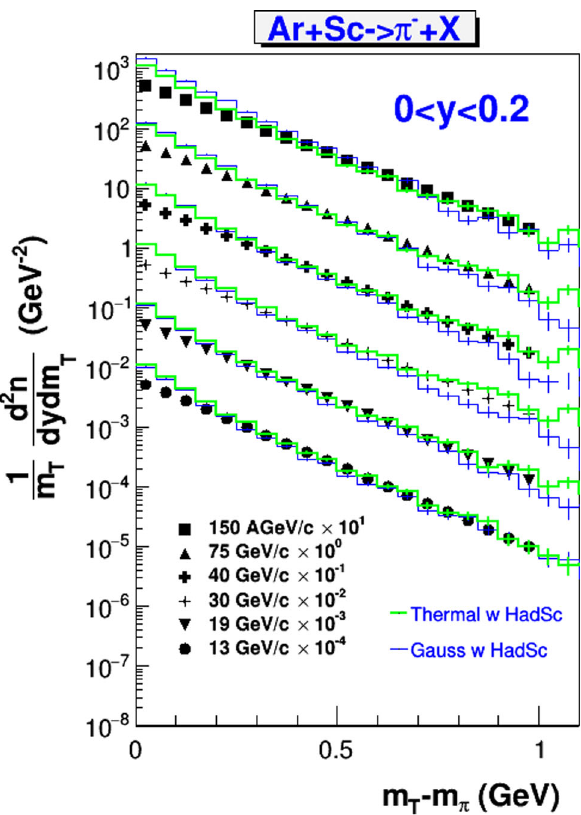
Fig. 10 The transverse mass spectra of π − in the 5% most central 40 Ar + 45 Sc collisions at mid-rapidity (0 < y < 0 . 2) for the whole SPS energies. The thin and thick lines denote the Gaussian and thermal models with primary hadron rescattering (HadSc), respectively. The closed points represent NA61/SHINE [9] data. For better readability, both the calculations and data points were